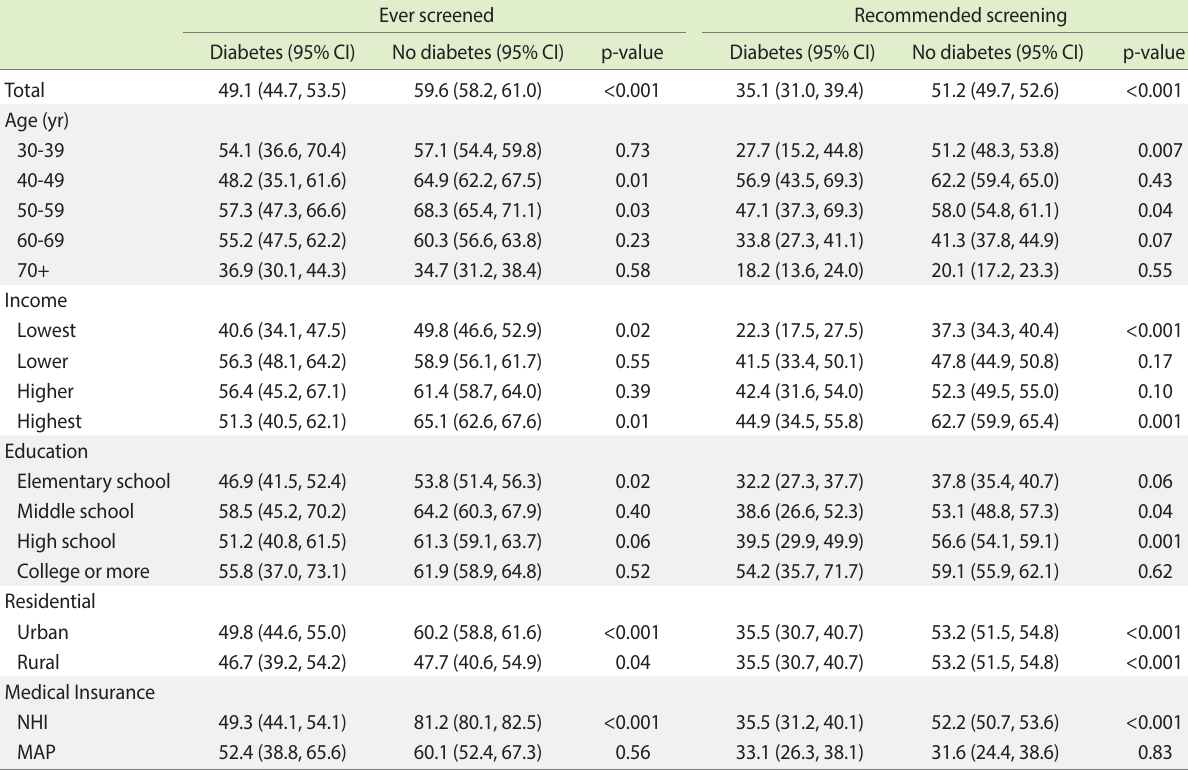
Table 4. Cervical cancer screening rate in diabetic and non-diabetic participants (ever screened and recommended screening) Ever screened Recommended screening